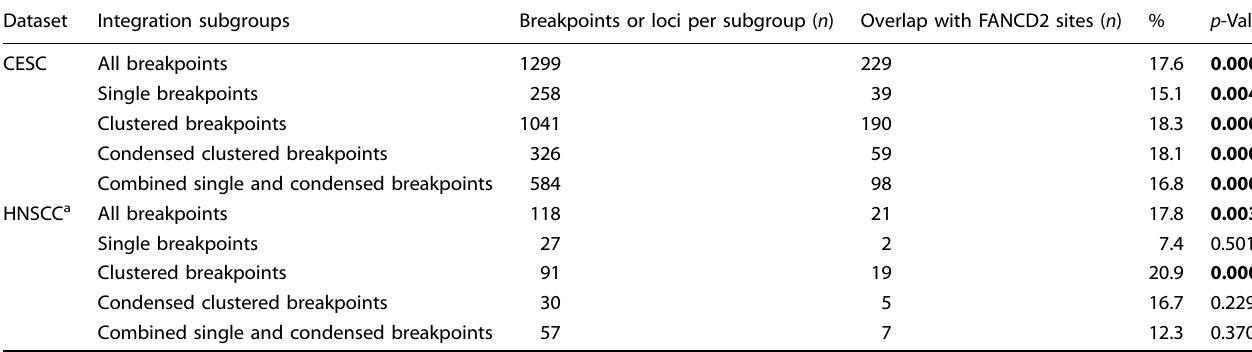
Table 1. Overlap of integration breakpoints with FANCD2-assocated fragile